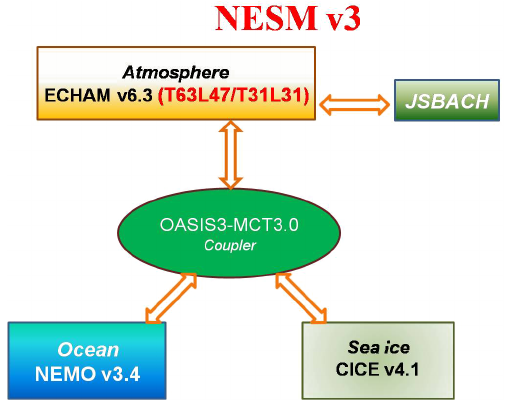
Figure 1. Coupled structure of NESM